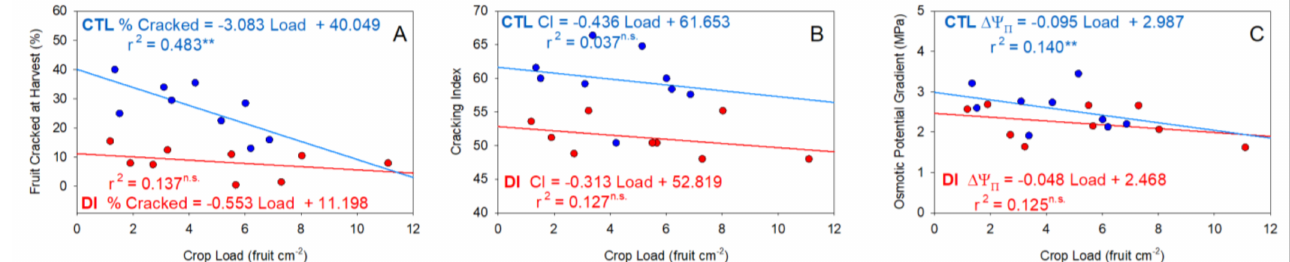
Figure 8. Linear regression between crop load and fruit cracked at harvest ( A ), cracking index ( B ), and osmotic potential gradient ( C ) for the two irrigation treatments: CTL (full irrigated treatment; blue) and DI (deficit irrigation treatment; red). ** indicates a significant relationship between the studied variables at p < 0.01 and n.s. indicates no significant relationship ( p >